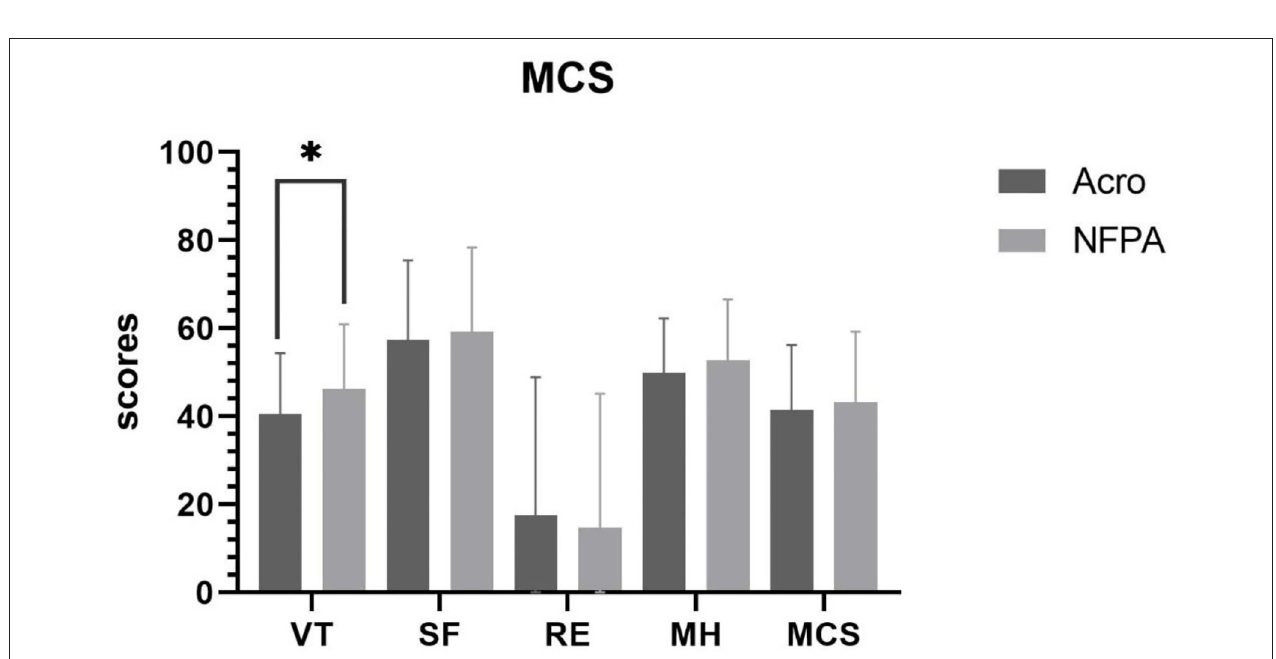
FIGURE 3 | Mental component summary score in patients with acromegaly vs. those with NFPA. Data are presented as mean ± standard deviation. VT, vitality; SF, social functioning; RE, role-emotional; MH, mental health; MCS, mental component summary. *Correlation is significant at the 0.05 level